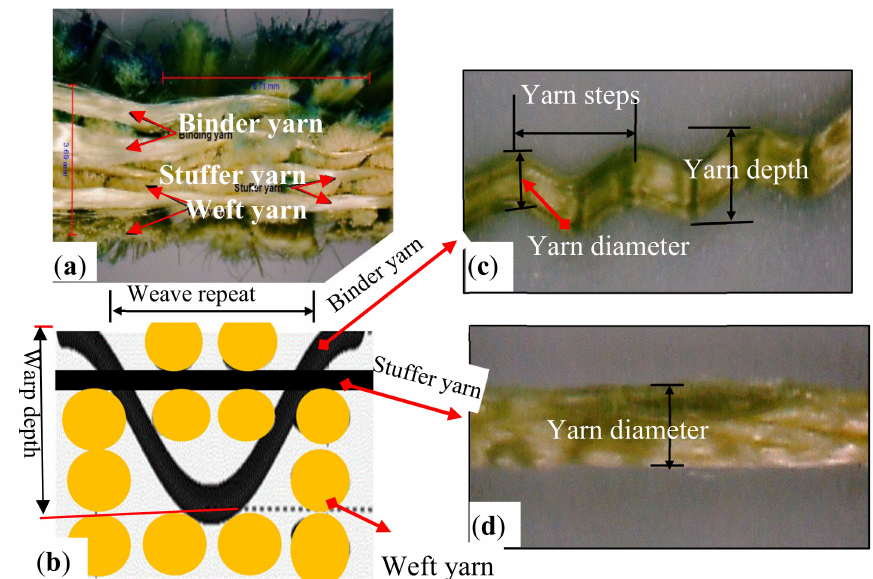
Figure 12. ( a ) Microscopic and ( b ) models of fabric cross-sectional view respectively, and ( c ) binder and ( d ) stu ff er warp yarn waviness inside the 3D warp interlock fabric